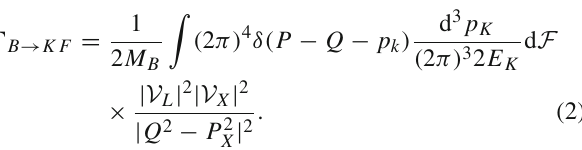
amplitude T F , represented schematically by the Feynman diagram in Fig. 1, as